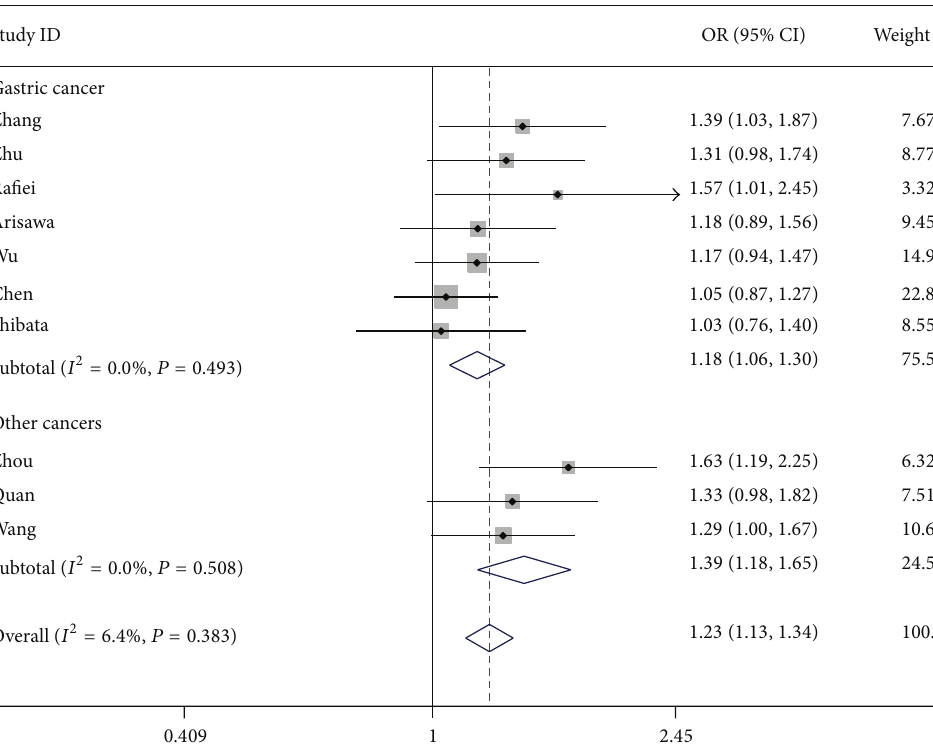
Figure 2: OR and 95% CIs for the association between IL-17A rs2275913G > A polymorphism with cancer risk for the GA + AA versus GG